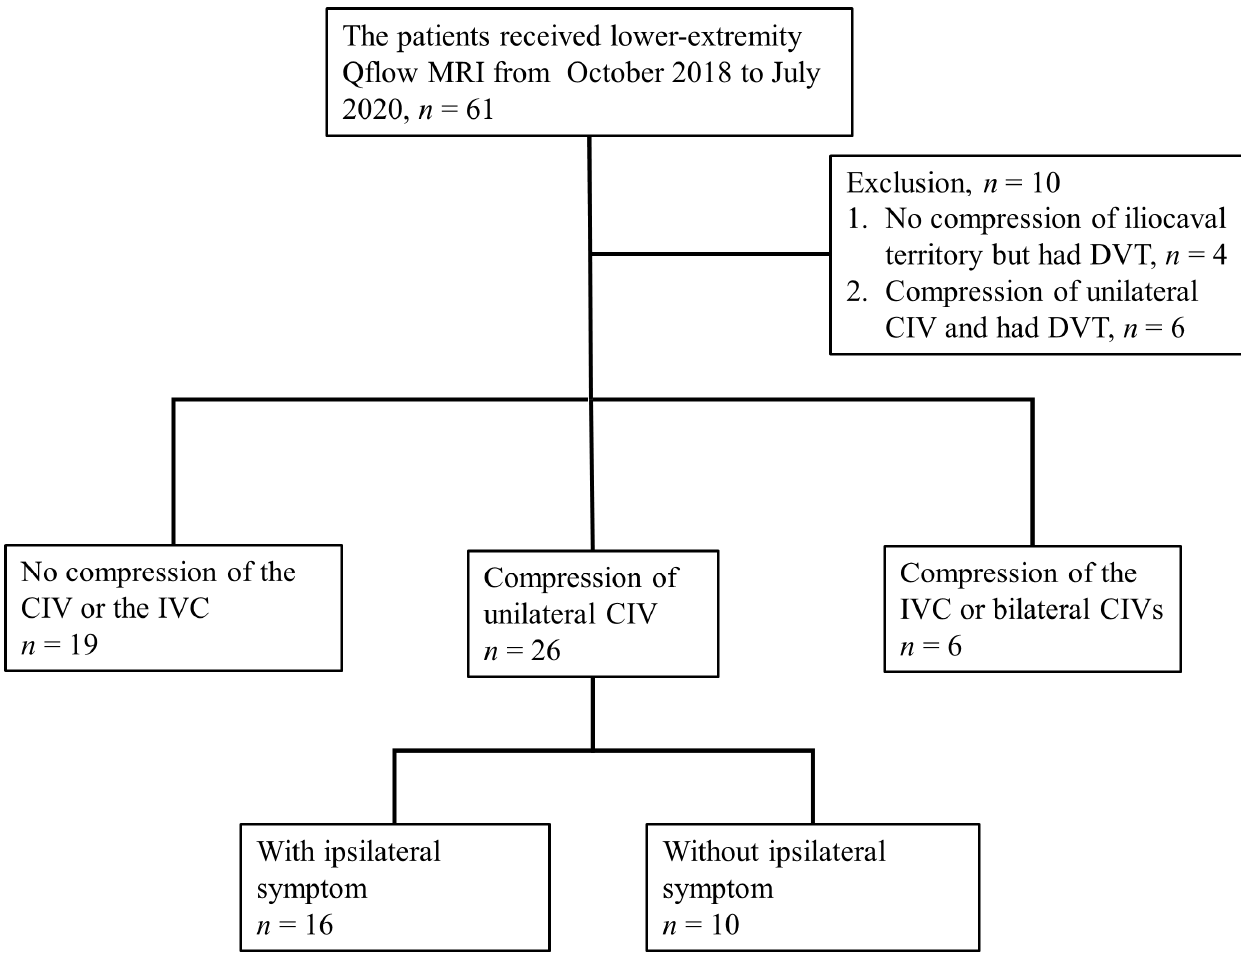
Figure 3. Hierarchy diagram. Abbreviations: CIV, common iliac vein; DVT, deep vein thrombosis; IVC, inferior vena cava; Qflow MRI, quantitative flow magnetic resonance imaging.